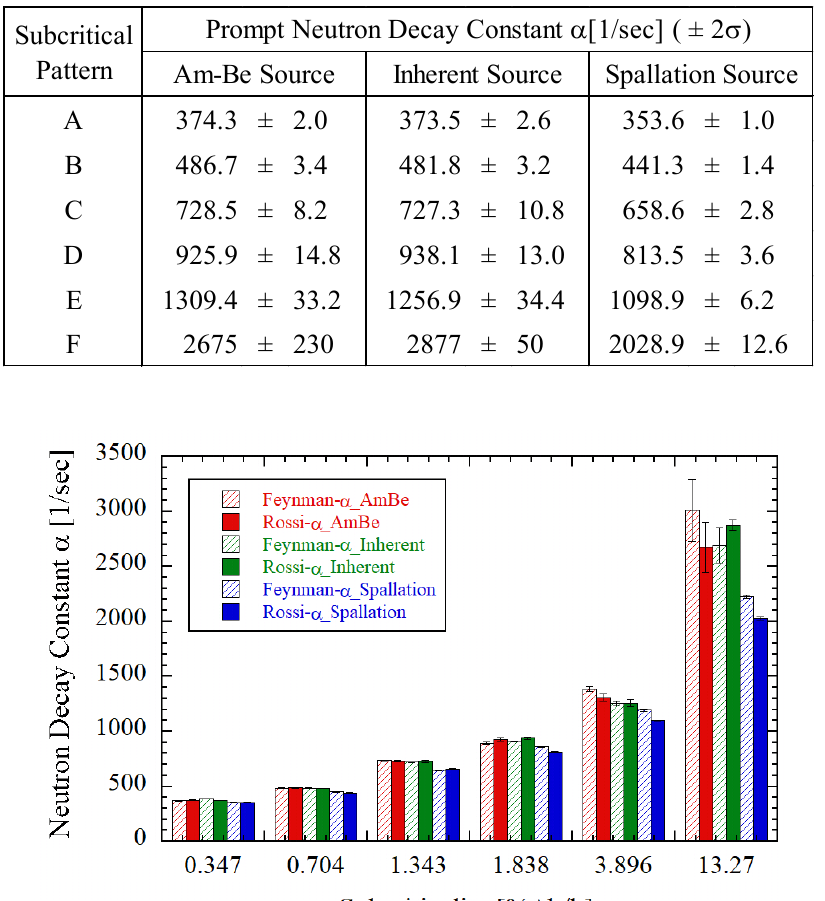
Table Ⅲ . Prompt decay constants determined by Rossi- α analysis